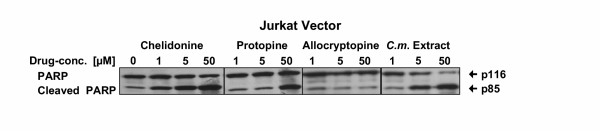
Chelidonium majus L. alkaloids induce PARP-cleavage. Jurkat Vector cells were treated for 24 h with medium or 1, 5 and 50 μM chelidonine, protopine, allocryptopine, and Chelidonium majus extract adjusted to 1, 5 or 50 μM chelidonine. Caspase-activation was then determined by Western blot analysis with antibodies specific for PARP and cleaved PARP. A representative experiment is shown.